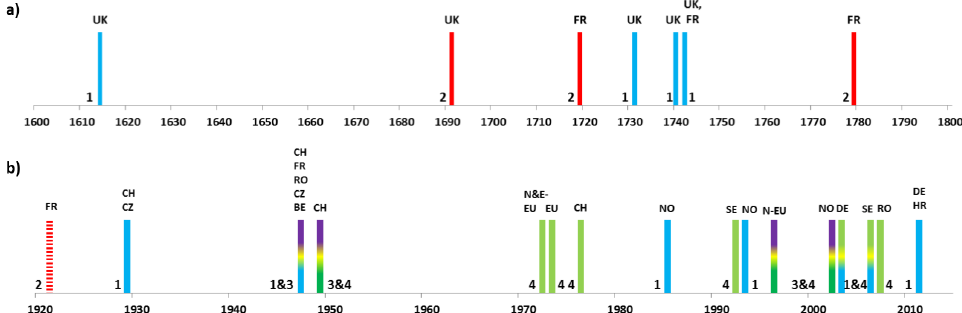
Figure 10. Selected drought events that are connected to winter temperature anomalies obtained from (a) historical archives, and (b) the EDII (except for the 1920 event, which is obtained from historical archives). (1) (blue): cold snow season drought , (2) (red): warm snow season drought ; (3) (purple): rain-to-snow-season drought , and (4) (green): snowmelt drought . Abbreviations represent countries in Europe (EU).